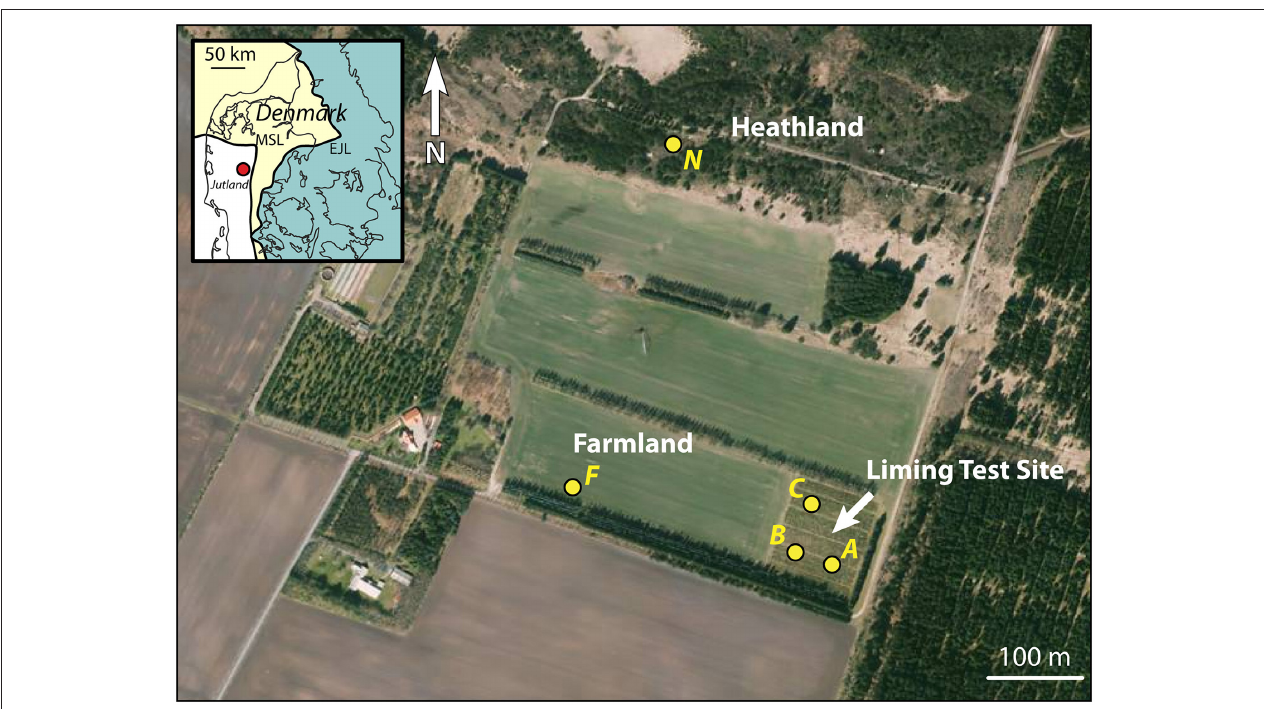
FIGURE 1 | Orthophoto from the spring of 2019 of the liming test site at Voulund with surrounding farm- and heathland. The locations of soil profiles (A, B, & C) within the liming test site, and F & N on farm- and heathland are indicated with yellow dots. Map insert shows the locality relative to the two major ice front locations during the Weichselian Ice Age ( Houmark-Nielsen, 2003). Orthophoto from Styrelsen for Dataforsyning og Effektivisering